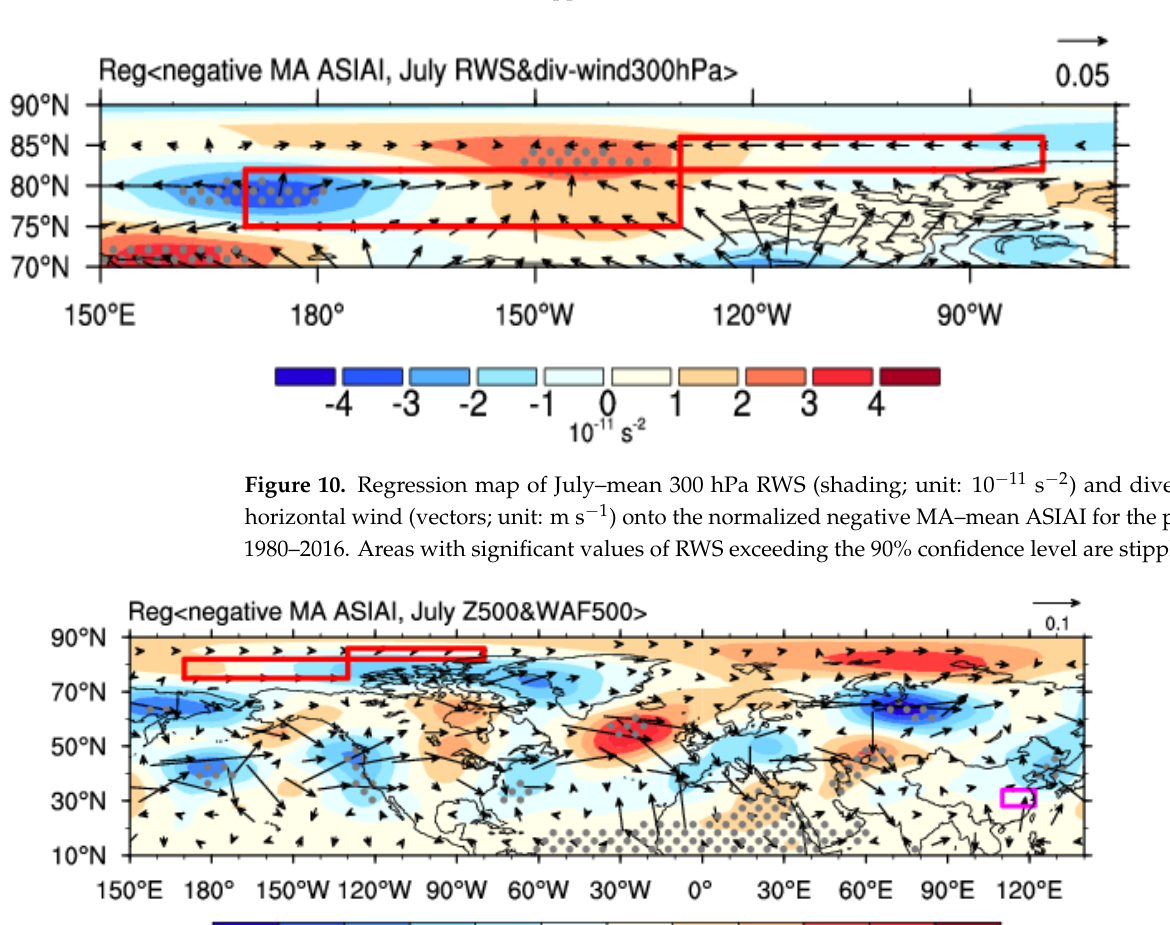
Figure 9. Correlations between the MA–mean ASIAI and the subsequent MJ–mean ( left panel ) and July–mean ( right panel ) Arctic SIA for the period 1980–2016. Correlation coefficients significant at the 95% confidence level are stippled.